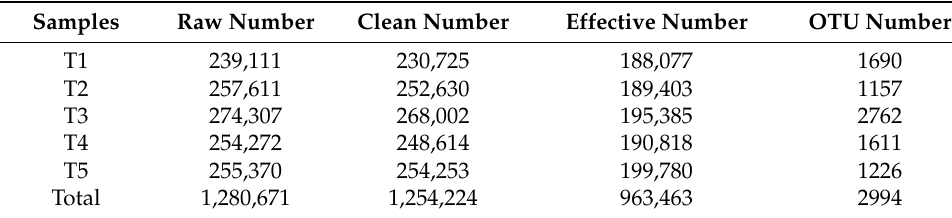
Table 3. Data statistics of genomic DNA sequences of soil